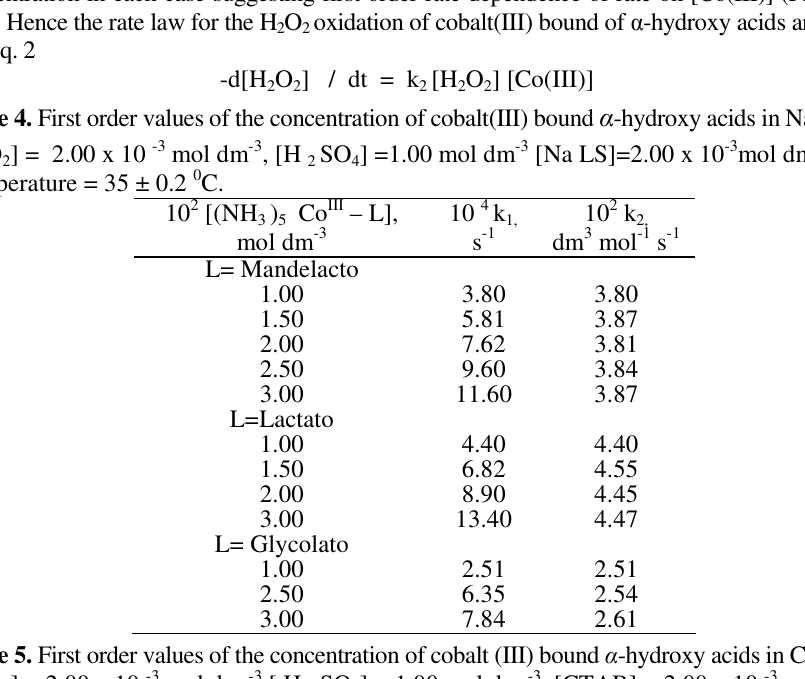
SO ] = 1.00 mol dm -3 , [CTAB] = 2.00 x 10 -3 mol dm -3 2 4